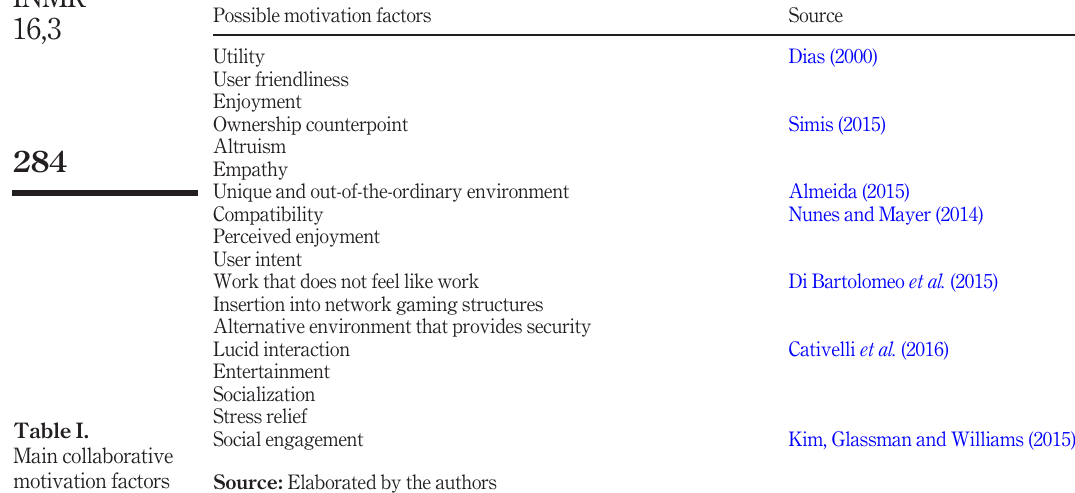
Table I. Main collaborative motivation